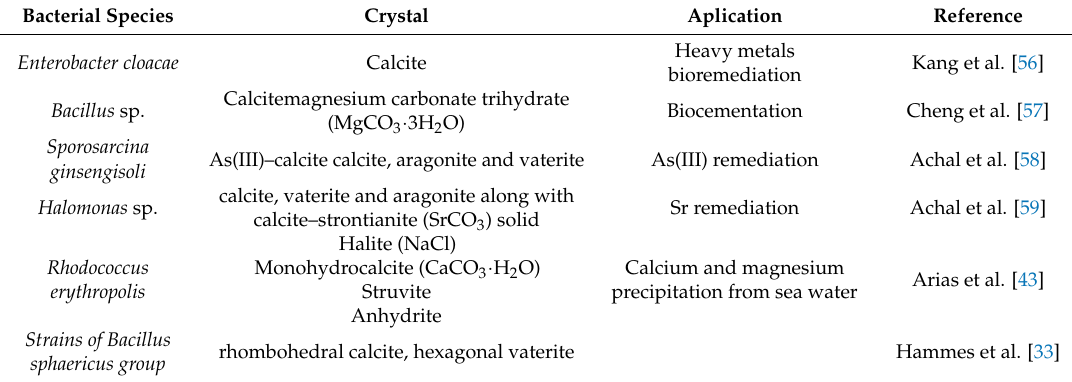
Table 1. Examples of crystals produced by ureolytic